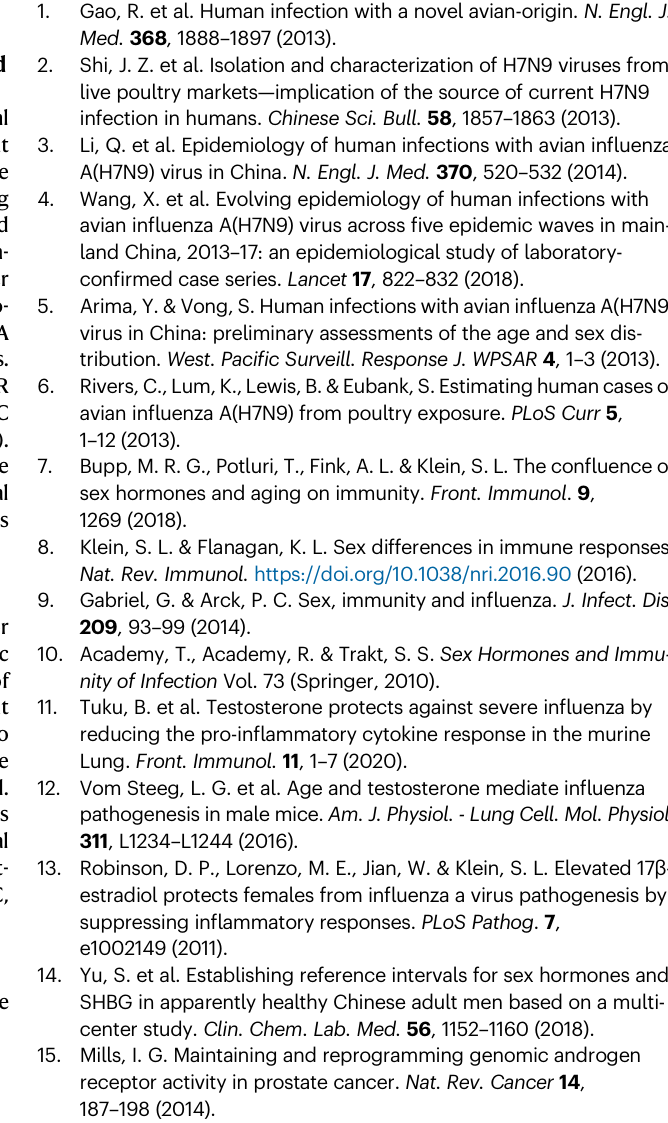
Fig. 6 | Infection with H7N9 reduces circulating testosterone levels and pro- motesanin fl ammatoryresponseinthetestesofmalemice.a Lungviraltitresof mice control-treated with Poly (I:C) ( n =6, 7 and 7) or infected with H7N9 virus ( n =15, 16 and 7) at 1, 3 and 6 d.p.i. b Viral NP mRNA expression levels in the testes frommicecontrol-treated withPoly(I:C)orinfected withH7N9virusat1d.p.i(Poly (I:C): n =6, H7N9: n =15), 3 d.p.i (Poly (I:C): n =7, H7N9: n =16) and 6 d.p.i.